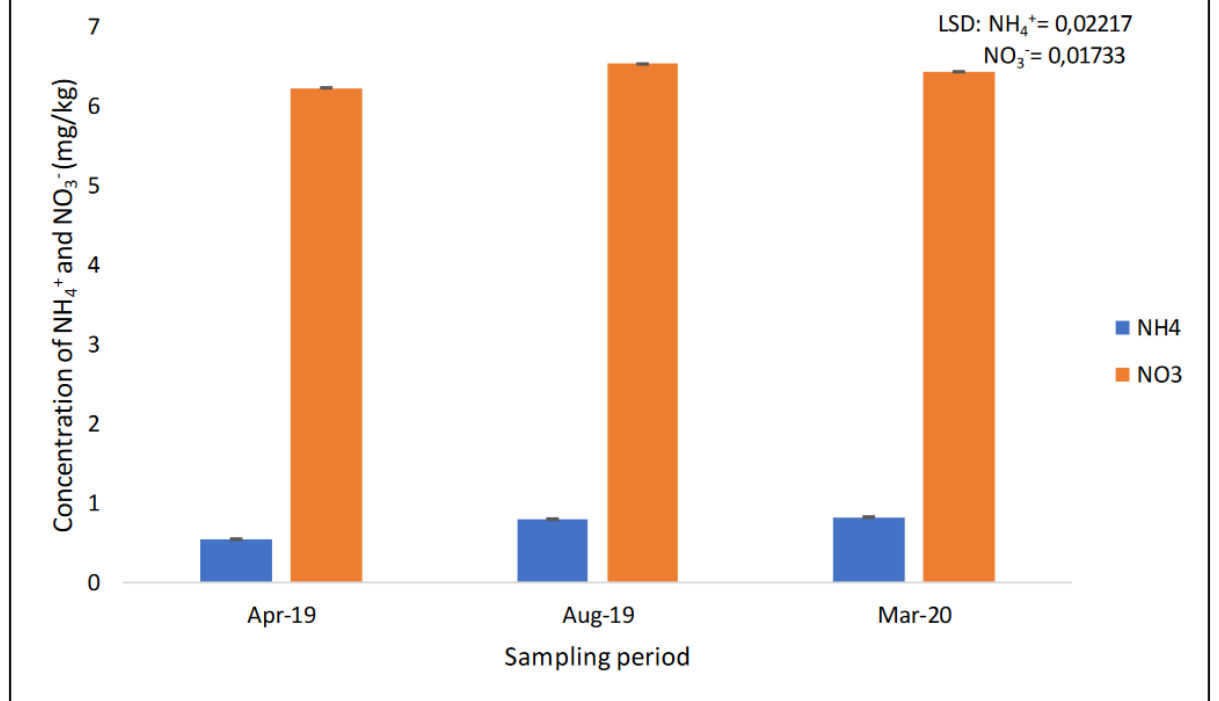
Figure 5. The concentration of extractable NO 3 − and NH 4+ across the three sampling periods recorded after 17 years of trial establishment.